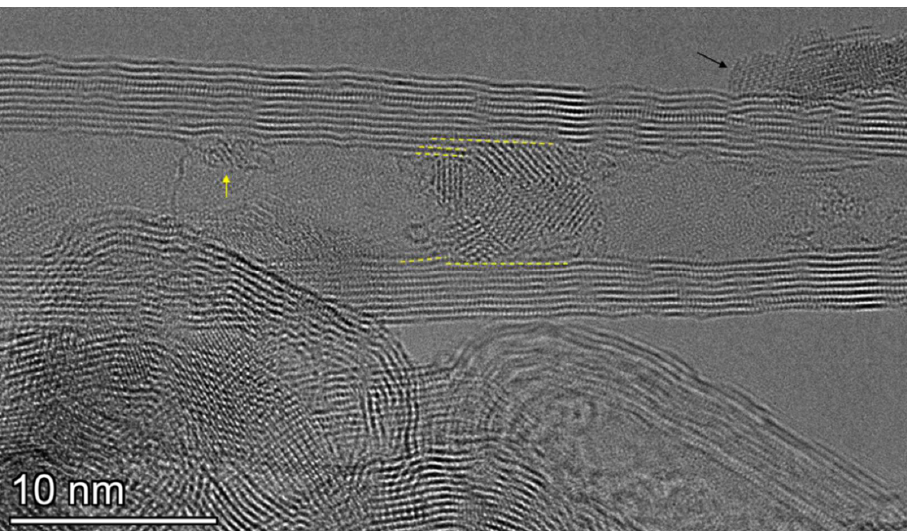
Figure A2. HRTEM image for the Pd-Ce-C catalyst showing single PdO nanoparticle (yellow arrow) and agglomerated PdO-CeO 2 nanoparticles located in the inner cavity of a carbon nanotube (yellow dashed lines indicate inner graphene layers contacting the agglomerate of nanoparticles), and an agglomerate of PdO and CeO 2 nanoparticles on the outer tube surface (black arrow). Figure A2 shows an HRTEM image of the Pd-Ce-C catalyst. In this picture, a single PdO nanoparticle (the interplanar distance is ~0.30 nm corresponds to the d 100 distance of the PdO phase) is located on the inner graphene layer of the nanotube (yellow arrow). Additionally, an agglomerate of PdO-CeO 2 particles presented on the HRTEM image is limited to the inner graphene layers forming the tube cavity (yellow dashed lines). This localization of the agglomerate most likely indicates its stabilization inside the tube channel. In contrast, the other agglomerate visible in this image (black arrow) is definitely located on the outer surface of the tube.